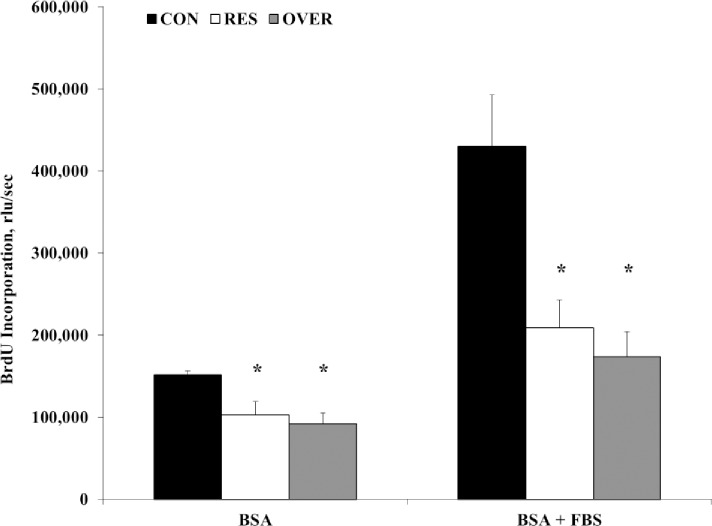
Poor maternal nutrition reduces proliferation of offspring mesenchymal stem cells.MSC were obtained from the offspring of control-fed (CON, n = 5), restricted-fed (RES, n = 6), and over-fed (OVER, n = 6) ewes at 1 day of age. Cells were cultured in the absence [bovine serum albumin (BSA)] or presence [BSA + fetal bovine serum (FBS)] of serum and proliferation was determined by 5-bromo-2'-deoxyuridine (BrdU) assay. Data are presented as mean ± standard error. *P < 0.01 rlu/sec = relative fluorescence units/sec.